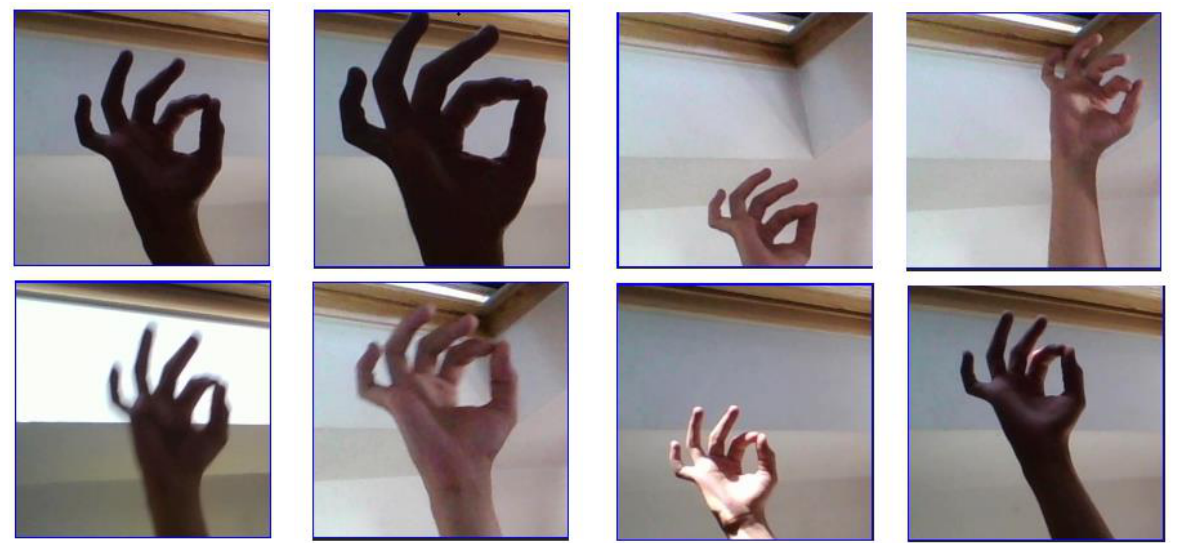
Figure 1. Test set visualization diversity for the letter F.